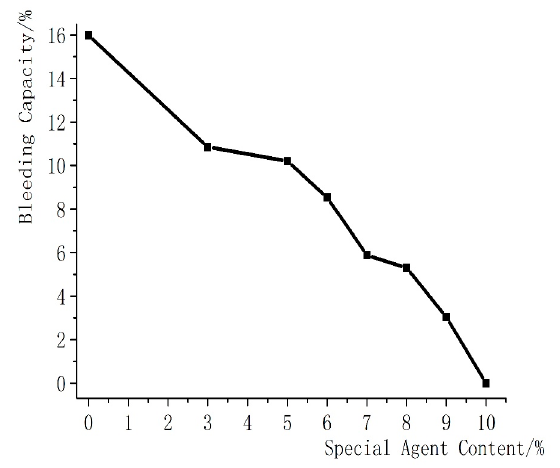
Figure 3. Effect of special additive on bleeding rate of slurry at 8 h.